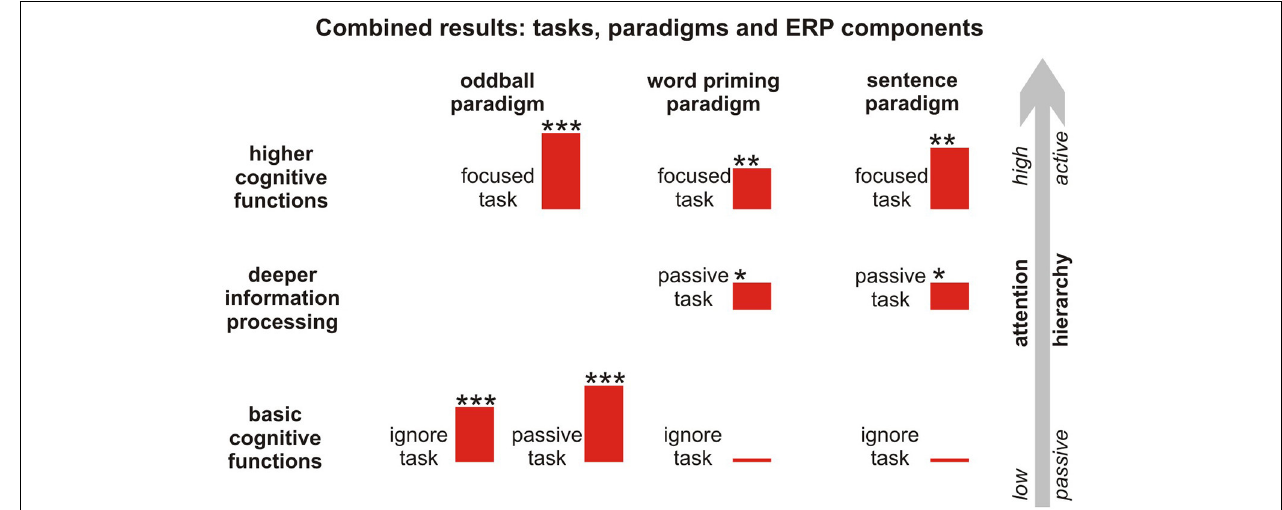
FIGURE 5 | Hierarchical approach to information processing including all attentional tasks, paradigms, and respective components. The red bars reflect the mean amplitude of the